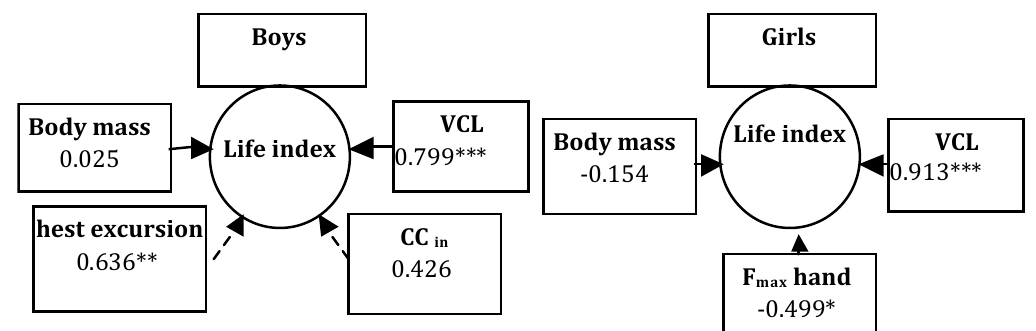
Fig. 4. Interconnection of life index with somatologic indicators of students – members of biathlon sport-pedagogic perfection group. CC chest circumference at inhale; in indicators, which compose index; indicators, which influence on index;